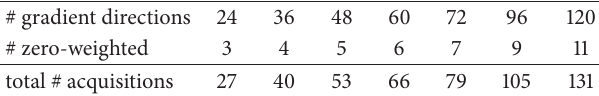
Table 1: Direction tables from our data.